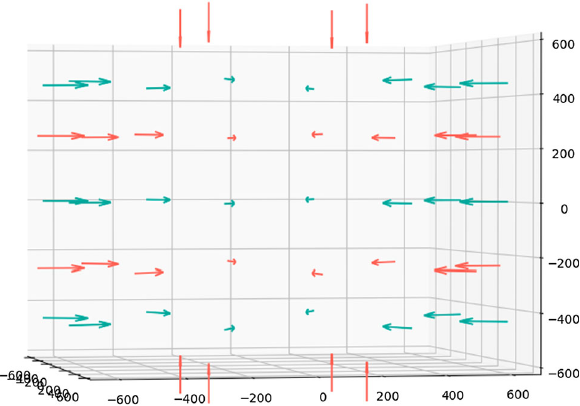
Fig. 3 Sketch of the orientation of each PMTs in the detector. Each arrow indicates a PMT location in the detector and the direction of the arrow indicates the direction of the face (photocathode) of the PMTs. Orange arrows corresponds to 8-in. PMTs while green arrows corre- spond to possible additional 2-in. PMTs